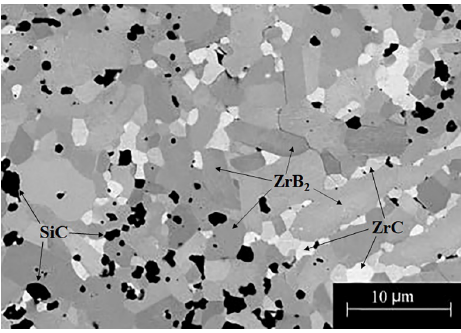
Fig. 4 Typical microstructure of ZrB 2 –ZrC–SiC produced by reactive sintering. Reproduced with permission from Ref. [115], © The American Ceramic Society